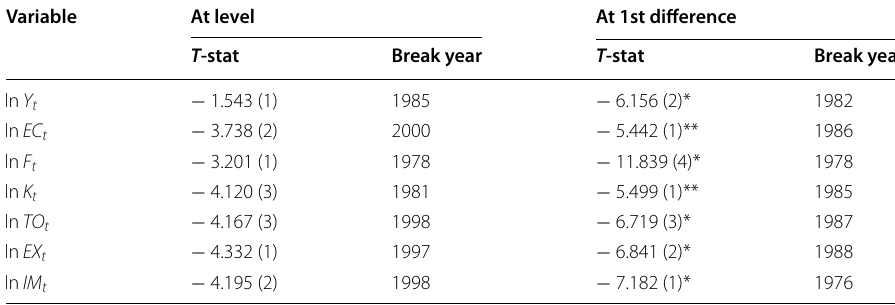
Table 2 Zivot–Andrews structural break trended unit root